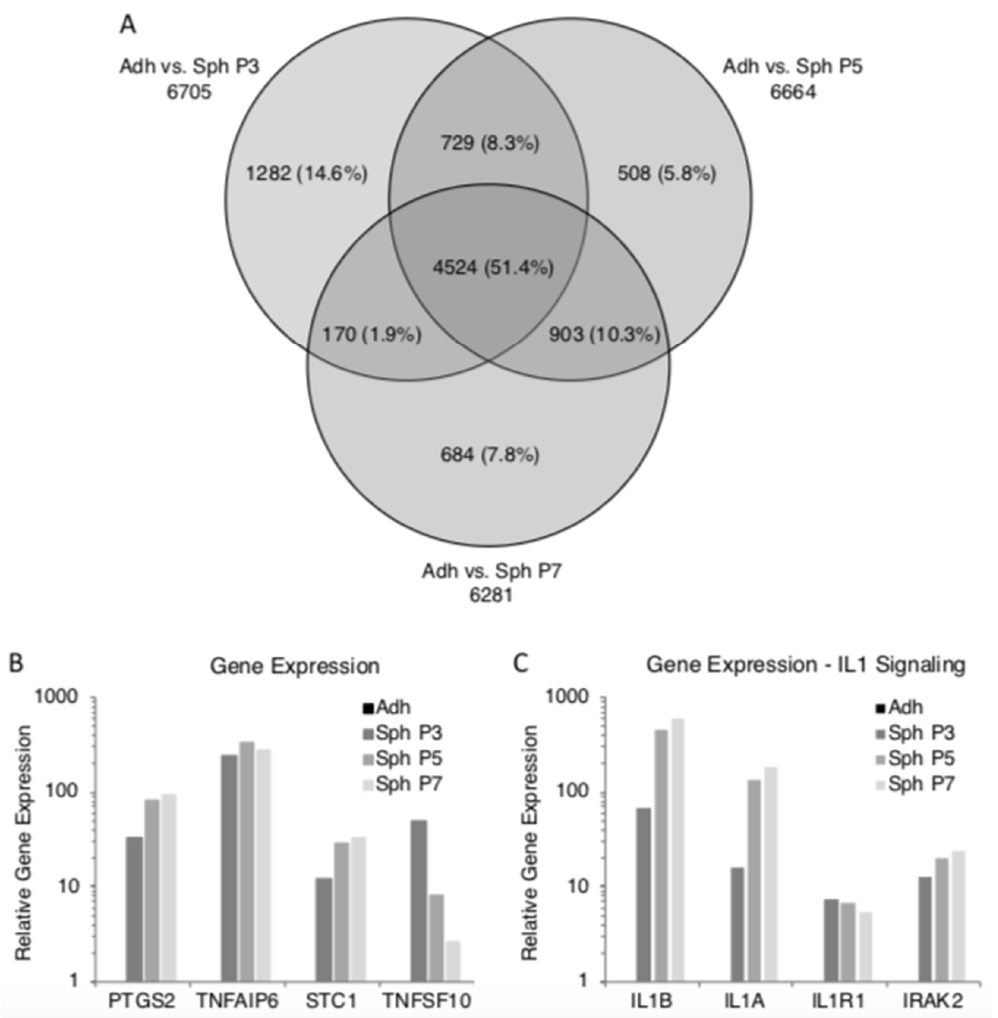
Figure 3. Spheroids generated from extensively expanded MSCs maintain high expression of potentially therapeutic molecules. Gene expression data were searched for differentially expressed genes between adherent monolayer MSCs and spheroids from various passages. Furthermore, the expression of potentially therapeutic genes and IL-1 signaling molecules were queried from the microarray data. ( A ) Venn diagram of differentially expressed genes. ( B ) Expression of potentially therapeutic genes in spheroid MSCs. ( C ) Expression of IL-1 signaling related genes in spheroid MSCs. Abbreviations: Adh, adherent monolayer MSCs; P3, passage 3; Sph, spheroid MSCs.